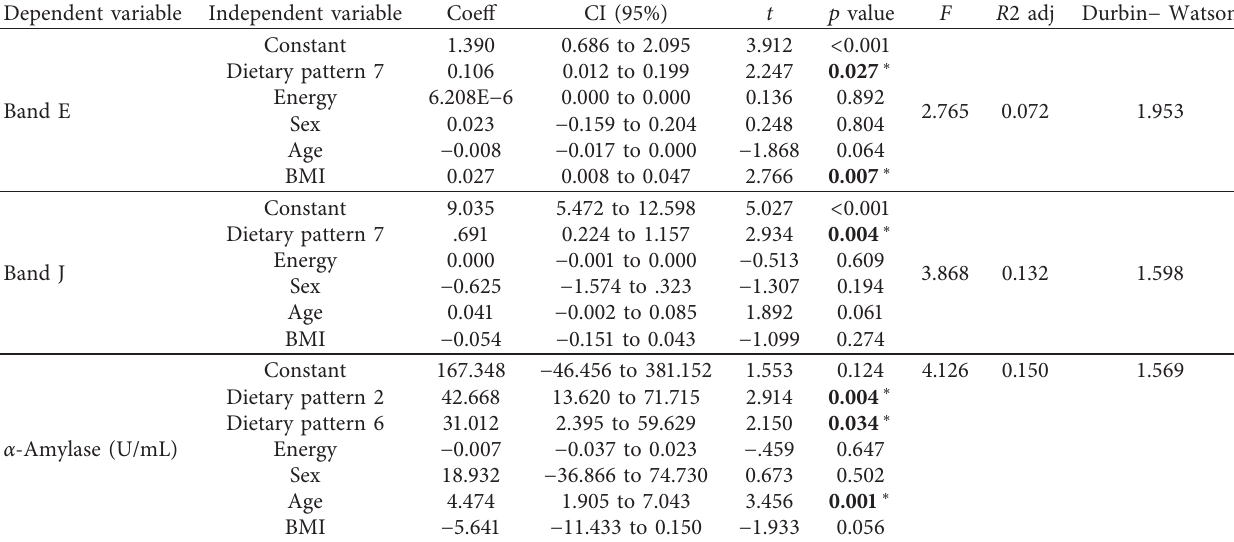
Table 4: Linear multiple regression models between dietary patterns and salivary